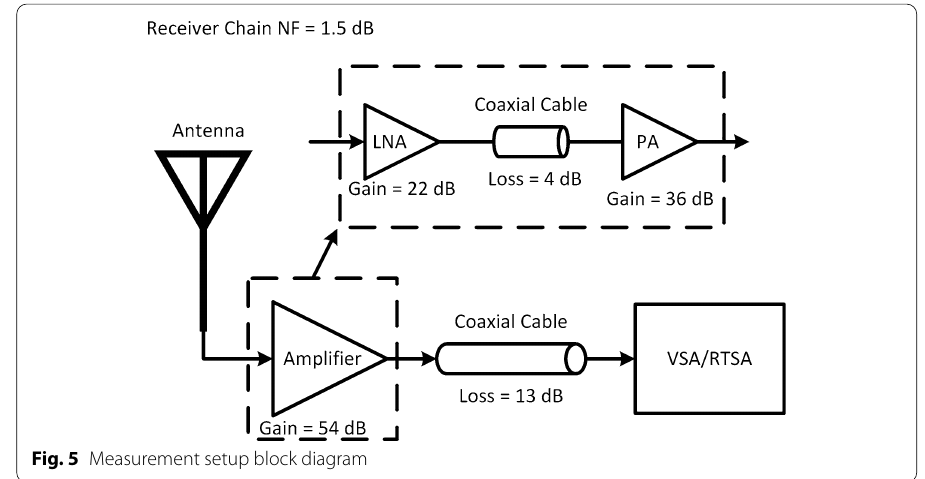
Fig. 5 Measurement setup block